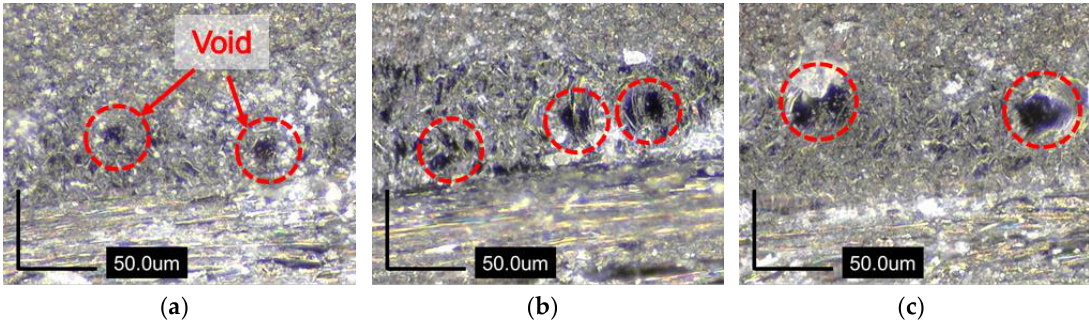
Figure 12. Cross section images in the center of specimens: ( a ) 10 plies; ( b ) 15 plies; ( c ) 20 plies.